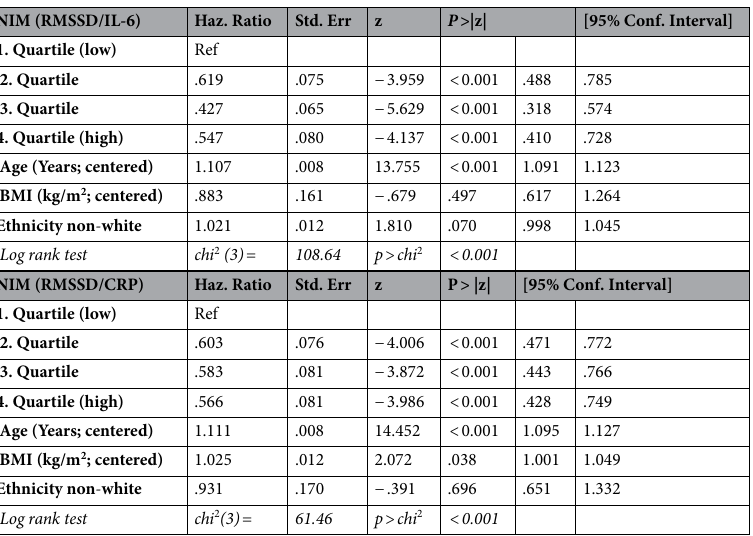
Table 2. Cox proportional hazards models (Observations N = 3860, No. of deaths = 429). Models were stratified by dataset (Whitehall II; MIDUS 2) and sex (male; female) NIM: Neuroimmunomodulatory index (RMSSD/CRP or RMSSD/IL-6). Haz.Ratio = Hazard Ratio; Std. Err. = Standard Error. Reading example : A white participant with an average age and BMI in the 4th Quartile group of NIM-IL6 were 45.3% less likely to die compared to participants from the 1st NIM-IL6 Quartile group, with a 95% confident between 27.2 and 59%. (i.e. we are 95% sure that participants in the Q4 group were between 27.2% and 59% less likely to die than participants in the Q1 group).